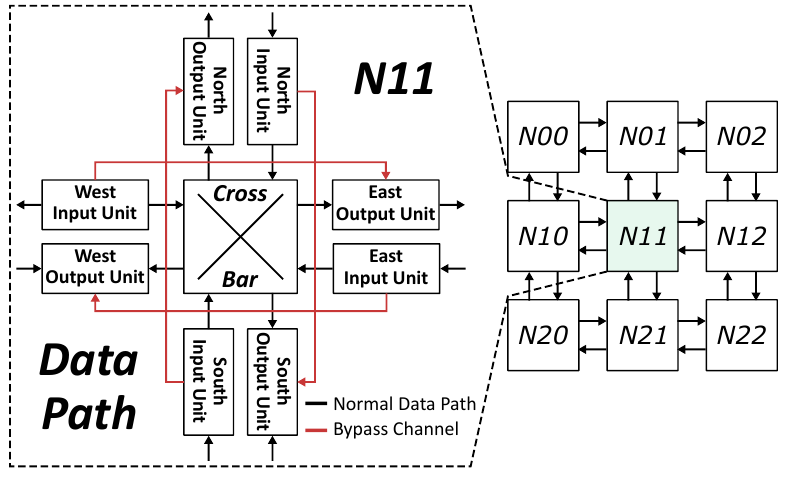
Figure 4. Architecture of the proposed